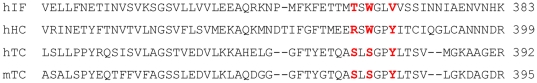
Partial protein sequence alignment of the predicted Cbi-binding region in human proteins.The alignment was done in ClustalW2 using default settings. The region of the three human proteins has previously been predicted to be involved in binding to Cbl and the highlighted residues are the ones expected to be responsible for the binding to Cbl (IF, TC, HC) and other corrinoids (HC only) [24]. For comparison, the similar residue positions in mouse TC are highlighted as well. The numbers in the right margin refer to the specific amino acids of the full-length protein including signal peptides. Complete protein sequence alignment is shown in Supporting Figure S1.